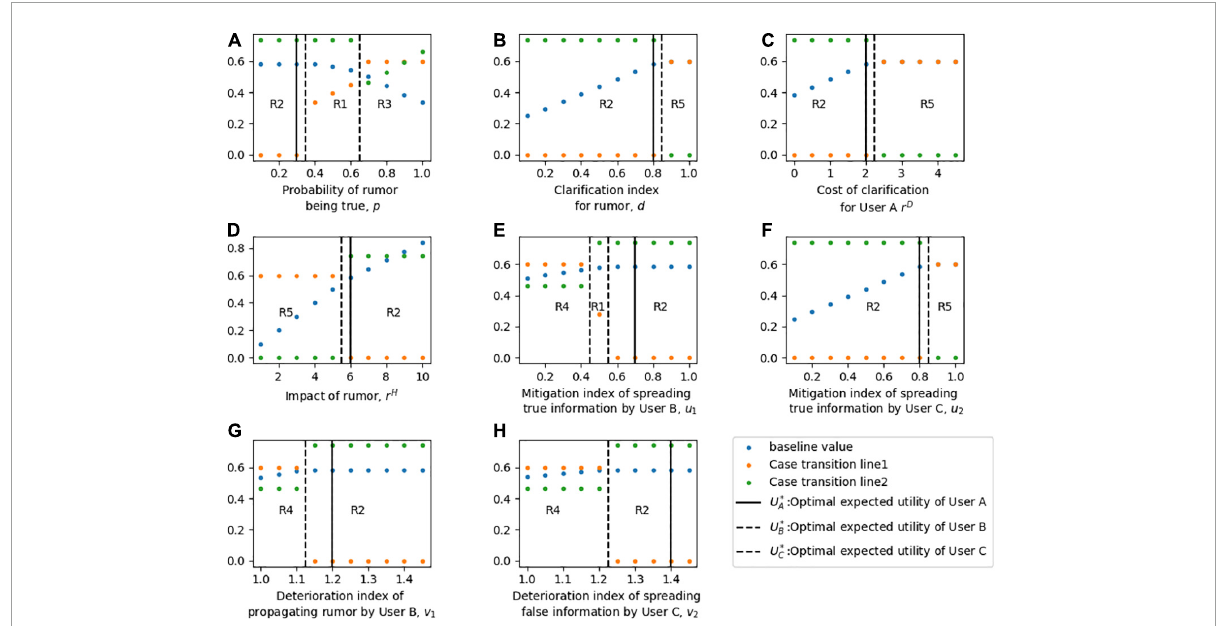
FIGURE4 Sensitivity analysis of the optimal strategies and expected utilities of three players. For part panel (A–H) , the x-axis represents the change of each parameter, the y-axis indicates the sensitivity of the equilibrium. R1-R5 in the part labels represents the different cases of strategy combination. The solid vertical line represents the baseline value of each parameter, and the dotted vertical line represents the transition of each